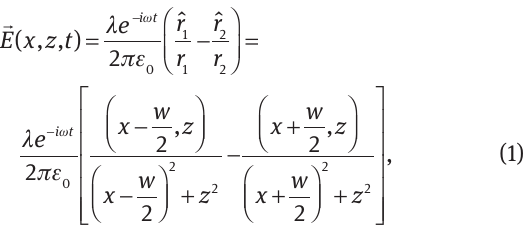
(cid:31) − σ ) w z x = ( , ) E x z when far away 2 2 πε + 2 x z 0 , z ) = (3 nm, 3 nm) together with | ψ ( x , 0, z )| 2 . The color 0 0 320